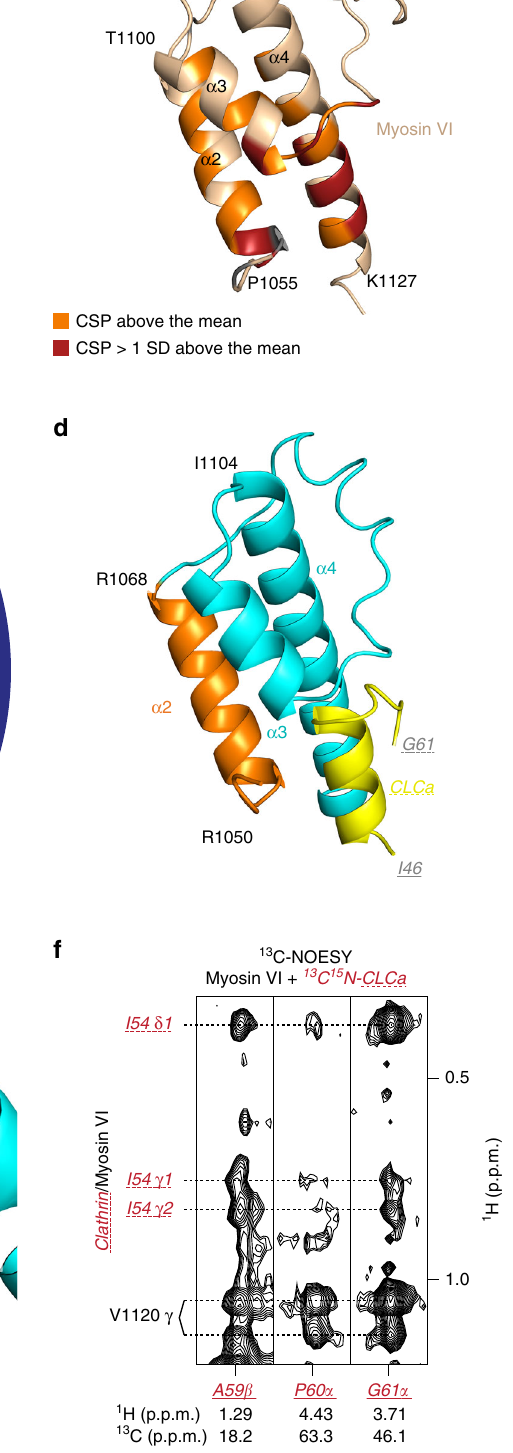
three helices and a disordered loop that follows the C-terminal end of isoform-speci fi c α 2. In agreement with our chemical shift index data (in Supplementary Fig. 6), CLCa 46 – 61 forms a short α - helix (yellow, Fig. 3c – e) that appears to complete the myosin VI structural domain by abutting the N-terminal end of α 3 and packing against α 2 and α 4 (Fig. 3d). At the C-terminal end, CLCa